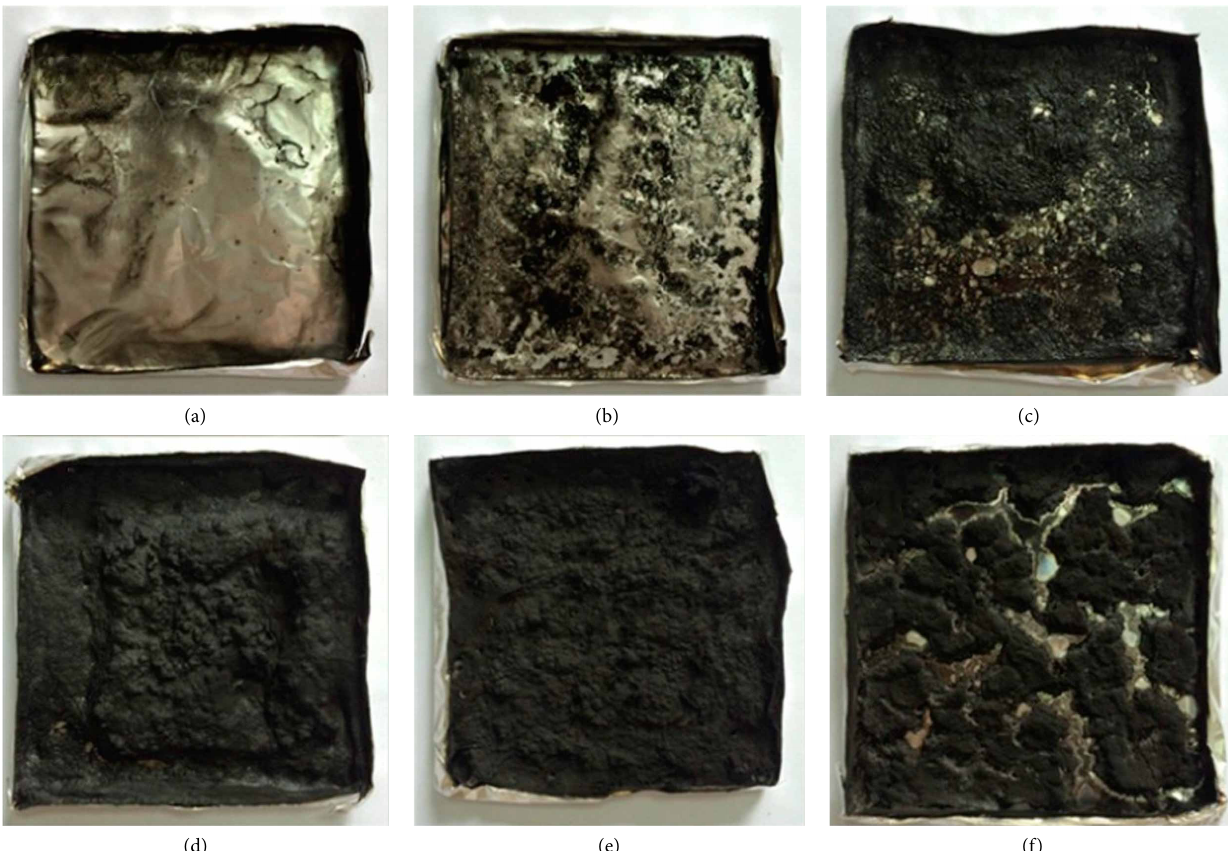
Figure 10: Digital photos of char residues of (a) PS, (b) PS/APP, (c) PS/CNAPP5, (d) PS/CNAPP10, (e) PS/CNAPP20, and (f) PS/CNAPP30 after the cone calorimetry measurement. Adapted from